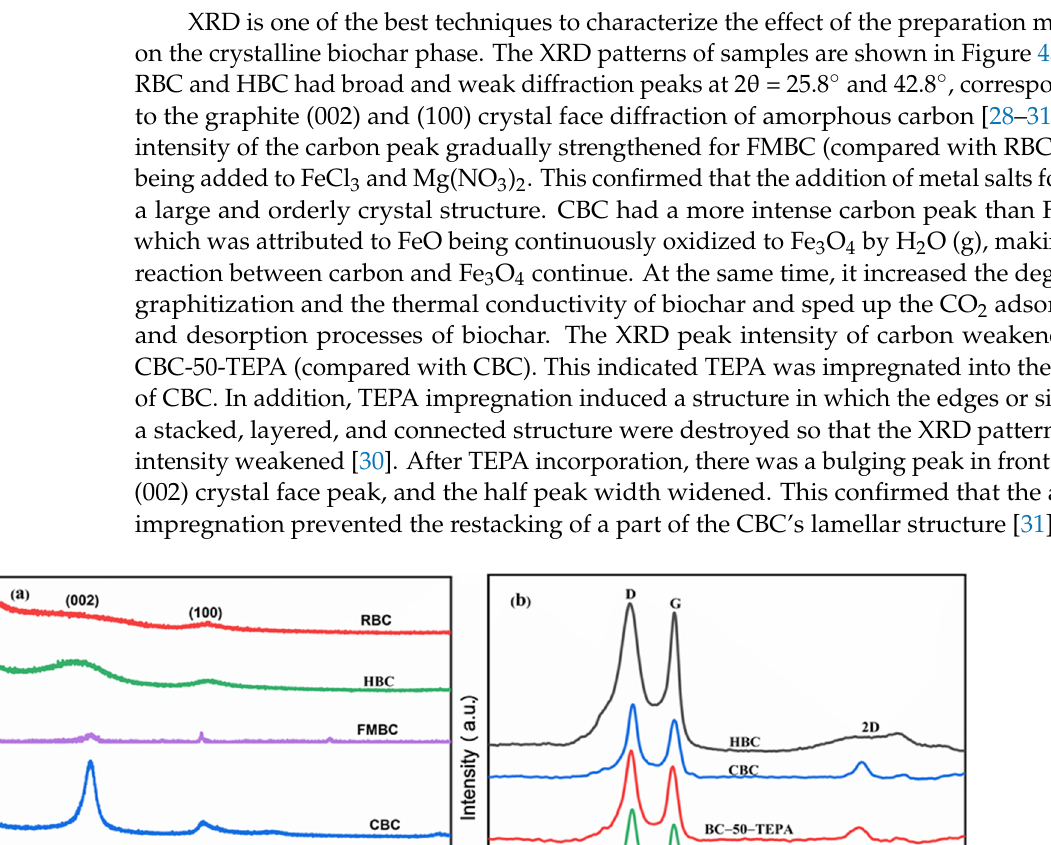
Figure 5. ( a ) Nitrogen adsorption − desorption isotherms and ( b ) pore diameter of biochar from dif- ferent activation methods and CBC-50-TEPA. Table 2 lists the specific pore properties of the RBC, HBC, FMBC, CBC, and CBC-50- TEPA. Comparing CBC with other biochars, S BET slightly increased. However, V T , S meso , and V meso significantly increased, which indicated the high efficiency of combining H 2 O